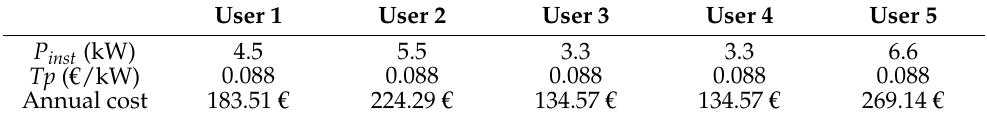
Table 5. Individual contracted power and the resulting costs.